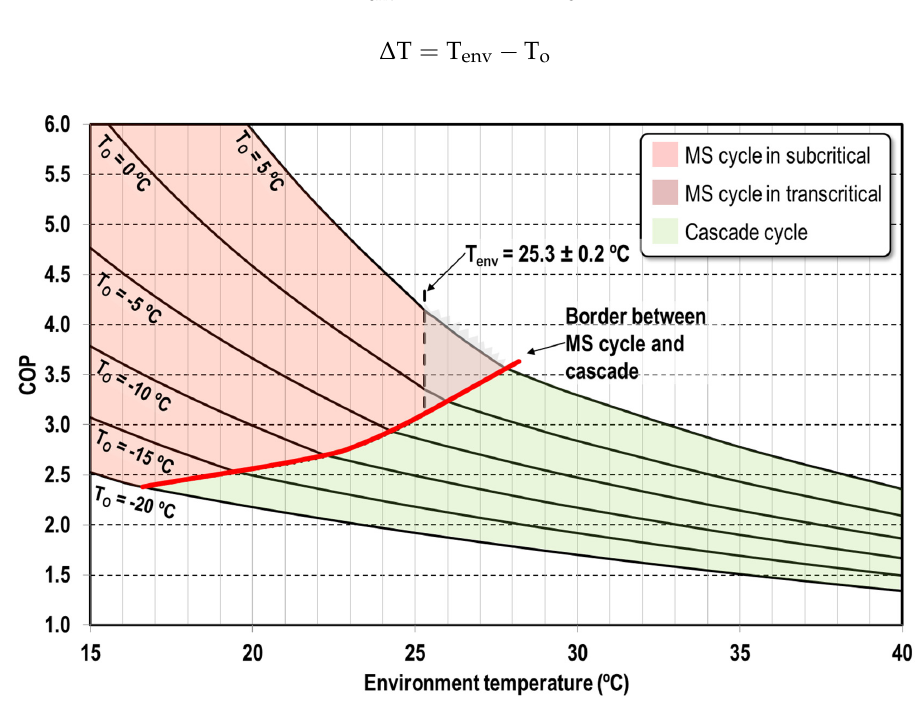
Figure 12. Best performing cycle for the different operating conditions.